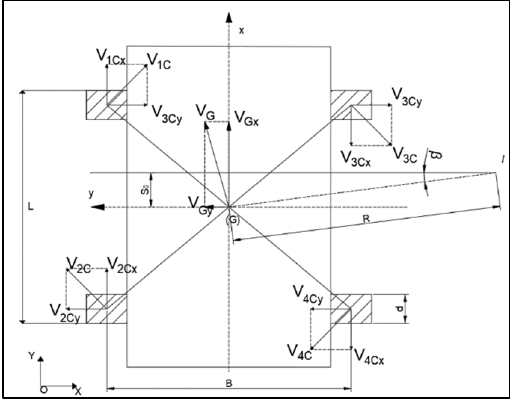
Figure 1. Mathematical model.